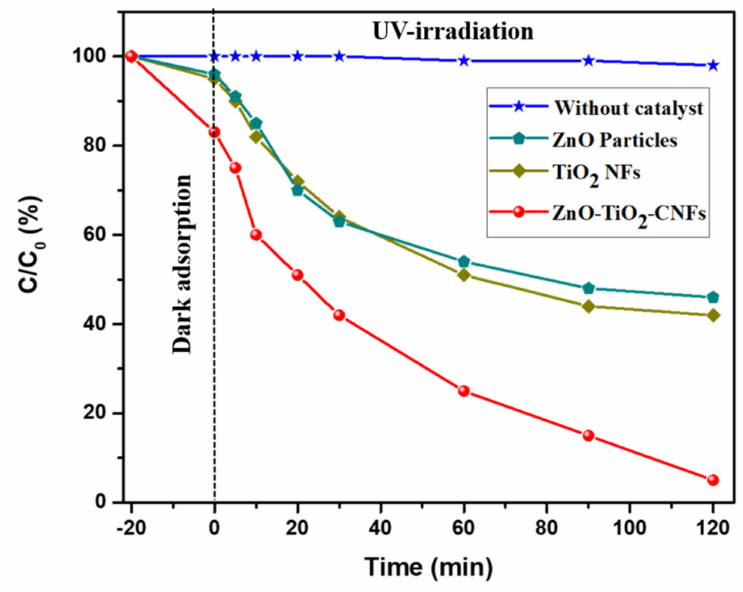
Figure 5. Photocatalytic methylene blue (MB) degradation using various photocatalysts under UV